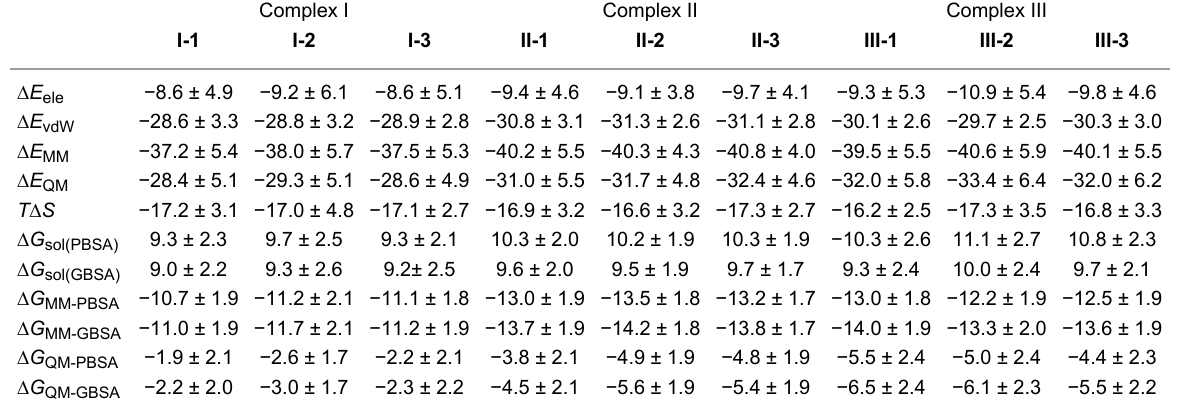
Table 2: MM- and QM-PBSA/GBSA binding free energies (kcal/mol) and their energy components for the nine systems of the fisetin/ β -CD